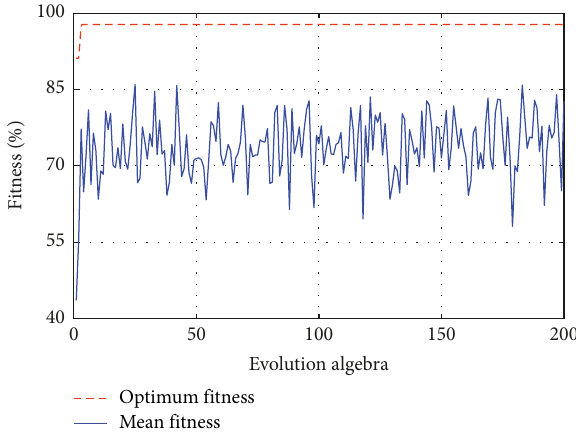
Figure 11: Identification results of the SVD value as the eigenvalue when noise signal is added into excitation.